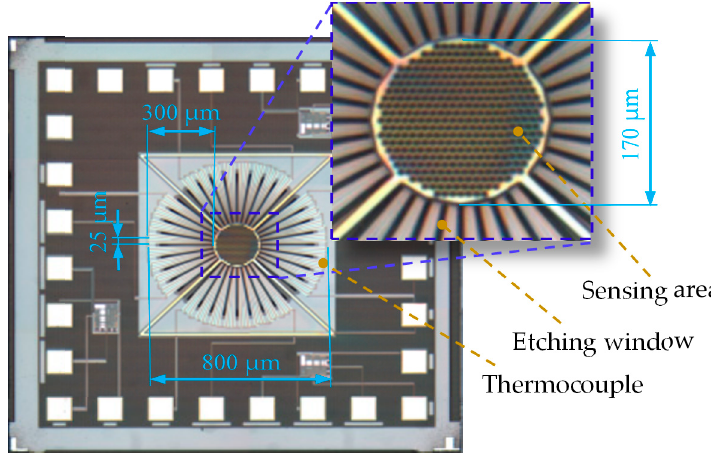
Figure 3. Microscope photograph of the proposed CMOS-MEMS thermopile.